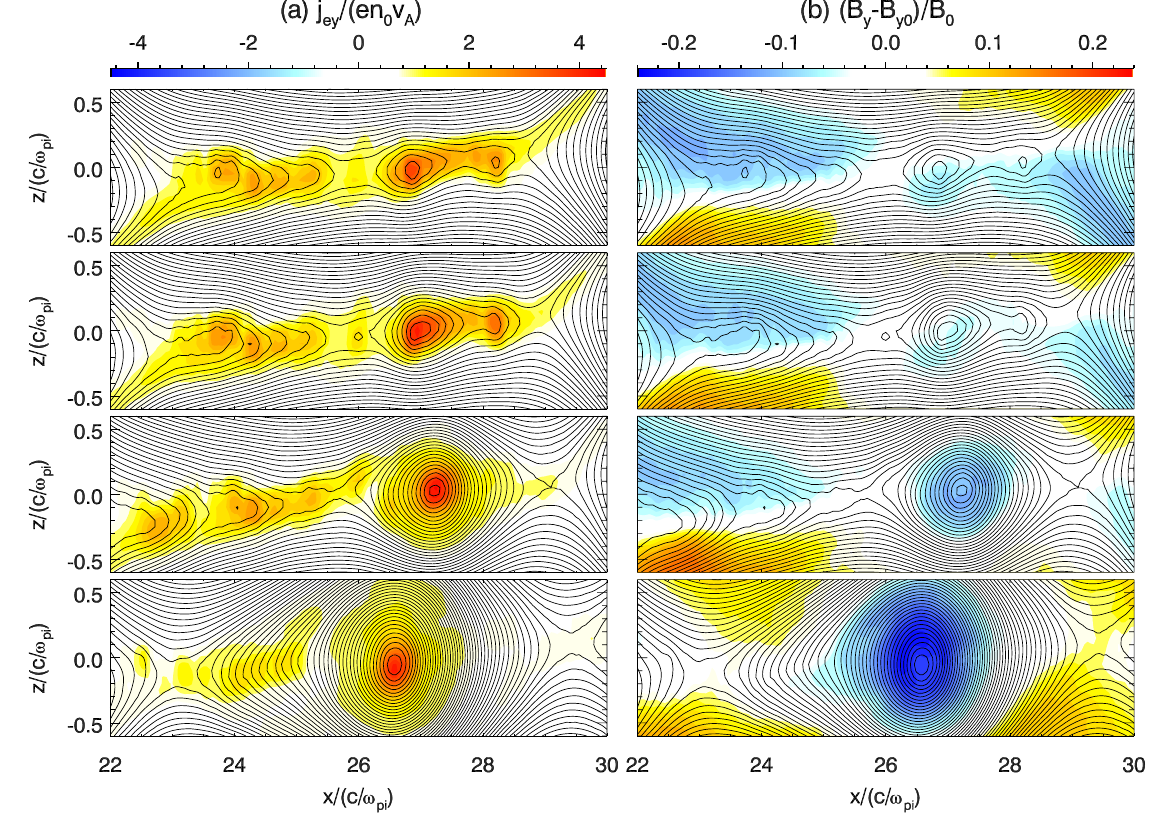
Fig. 4. The contours of (a) the electron currents along the y direction j e y , and (b) the out-of-plane magnetic field (B y − B y 0 )/B 0 at (cid:127) i t = 29, 29.5, 30.5 and 33.5 from the top to the bottom panels. The magnetic field lines (solid lines) are also represented in the figure.